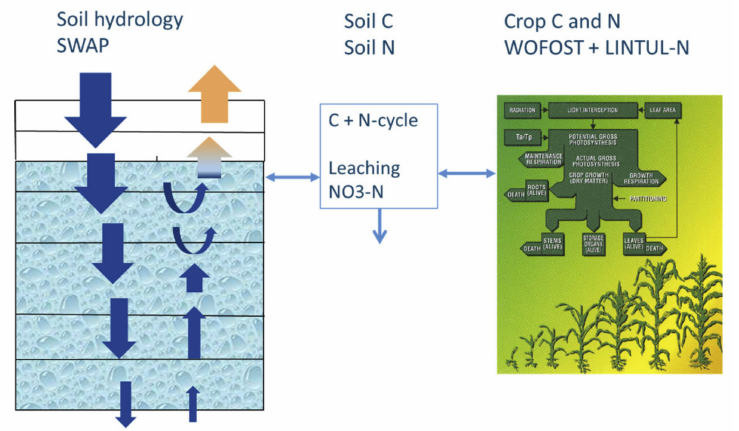
Figure 3. Schematic representation of the three modules in the innovated SWAP-WOFOST-N model